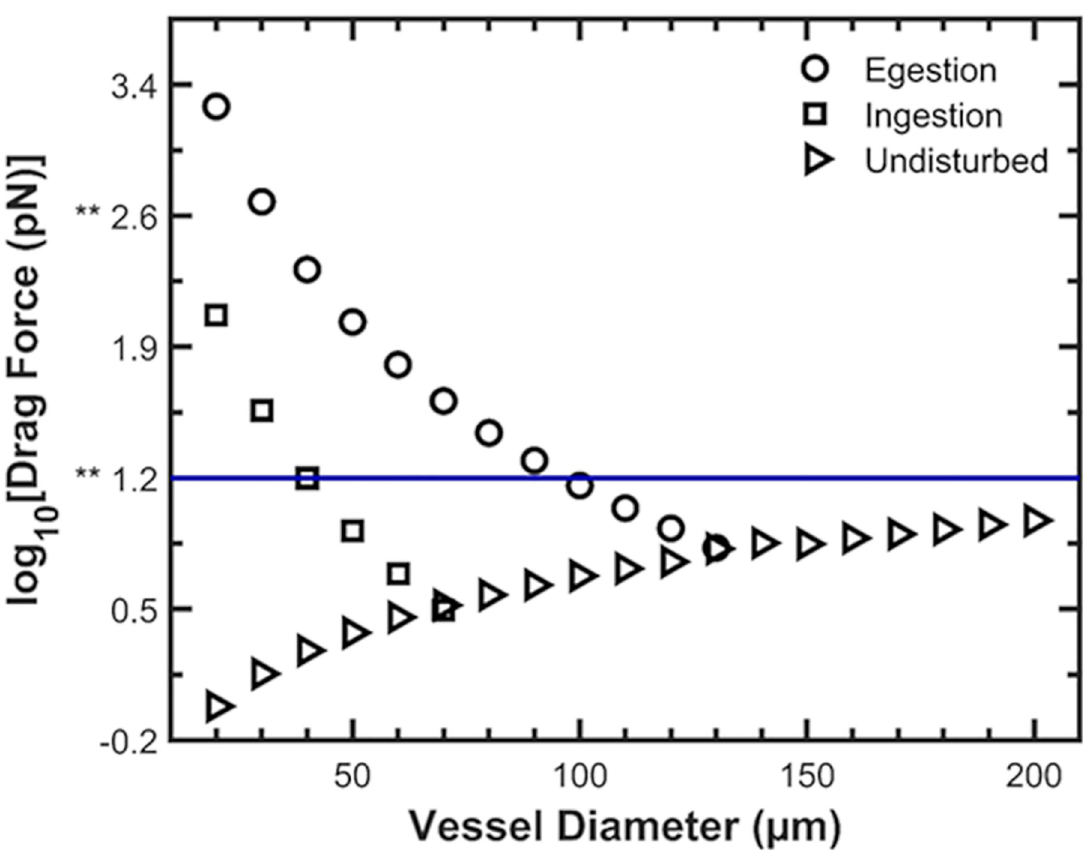
Fig 2. Simulated drag forces acting on individual, surface-attached bacteria in grapevine xylem vessels. ‘Egestion’ and ‘Ingestion’ indicate simulated fluid flow for insect-xylem interactions during these respective activities. ‘Undisturbed’ indicates simulated undisturbed xylem vessels by modeling the water tension gradient as a pressure gradient. The �� symbols on the y-axis are references to key drag forces in the results of a previous microfluidic study [29]. The blue horizontal line is a visual aid at 10 1.2 pN (15.85 pN) that represents the drag force where less than 1% of individually surface-attached Xylella fastidiosa cells detached in De la Fuente et al. [29]. When the drag forces in that same study were sequentially increased in our model, over 70% of X. fastidiosa detached by the time the drag forces reached 10 2.6 pN (443.8 pN)